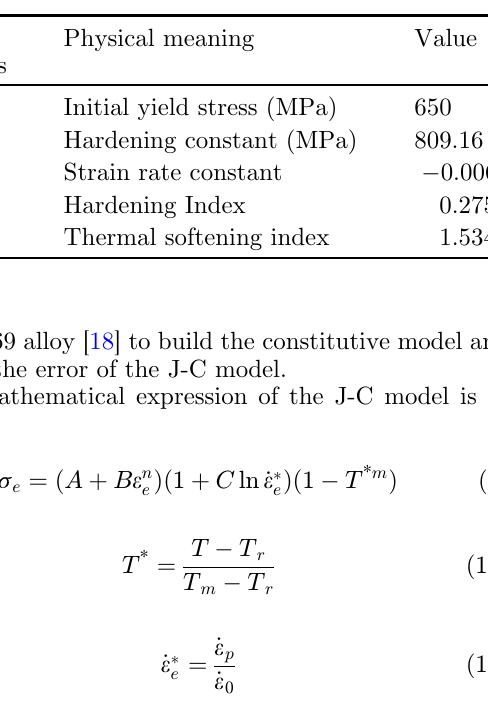
Fig. 2. Operating process of the calculation program.